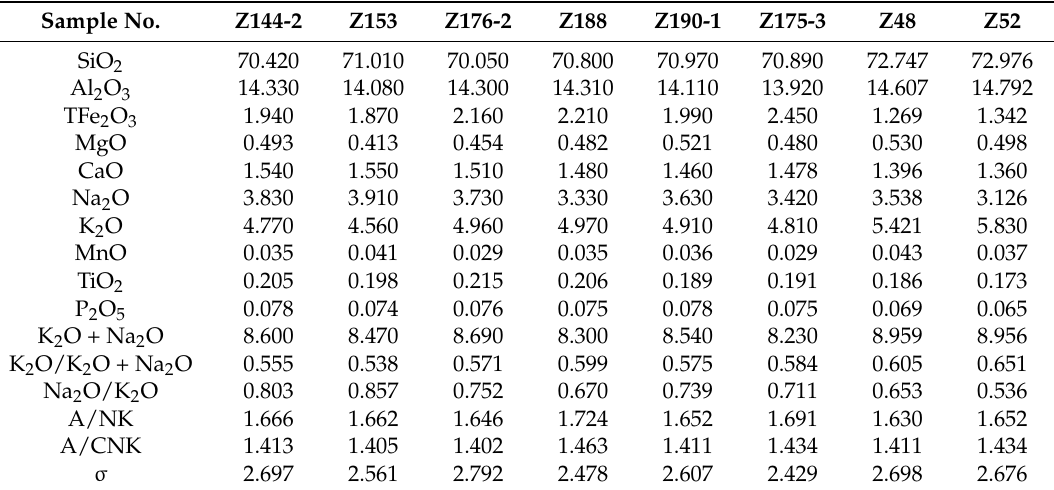
Table 3. Chemical composition of the Xiajinbao granite (wt %). Sample No.